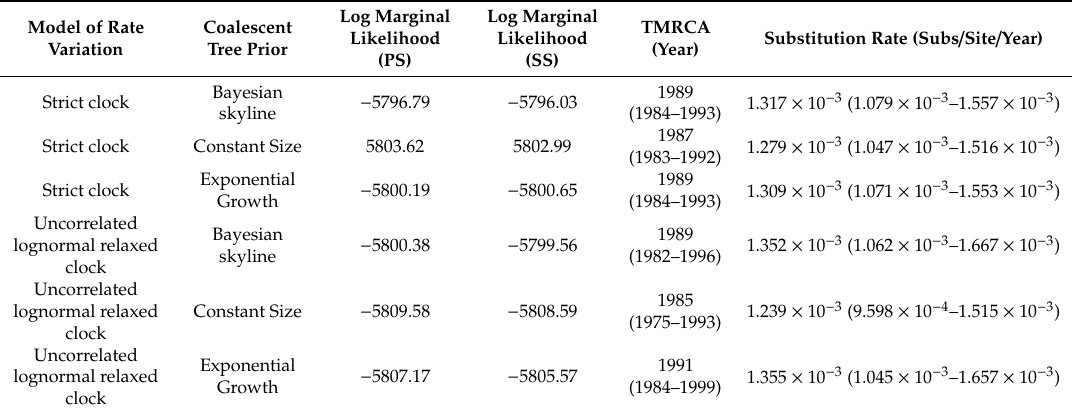
Table 1. Candidate phylodynamic models for VI.2.1.1.2.2 PPMV-1